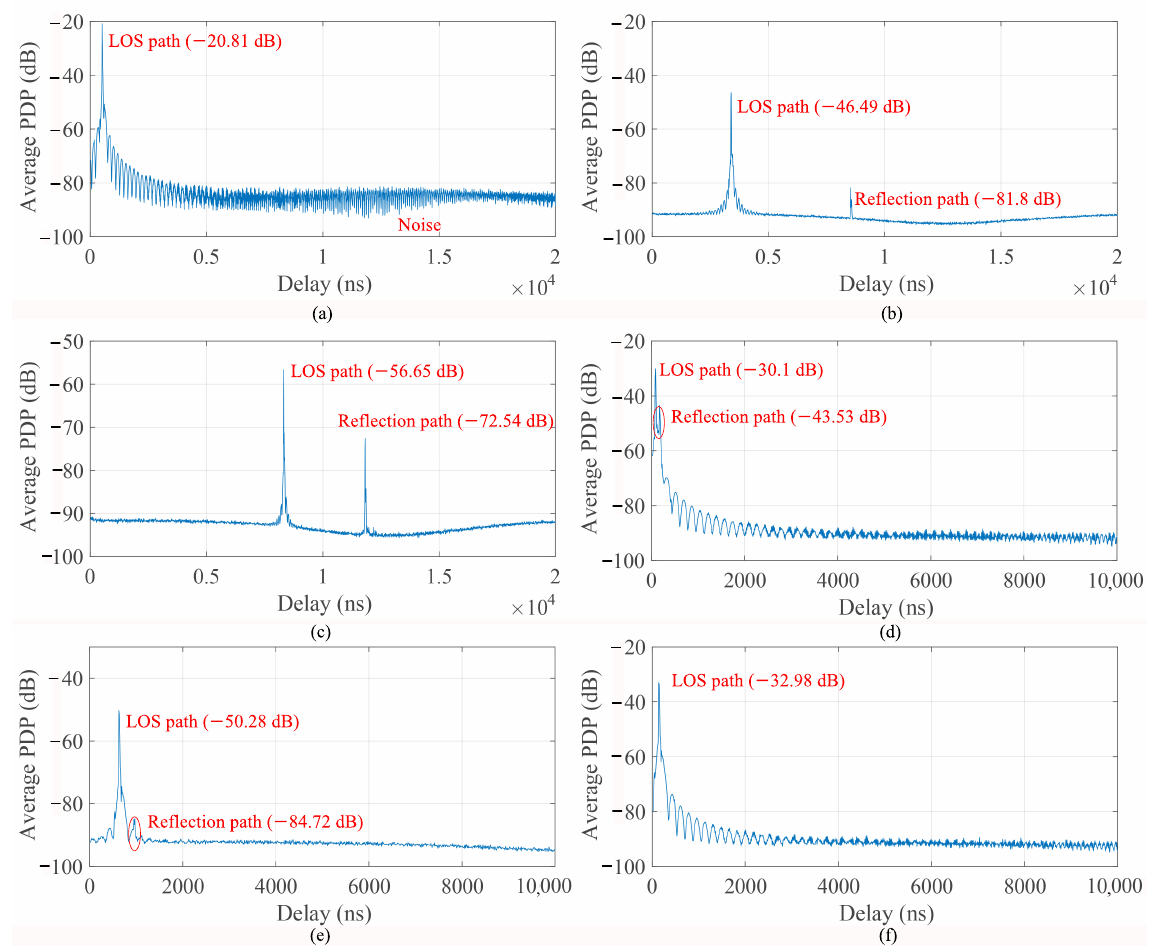
Figure 3. Average PDP from the three selected areas. ( a – c ) are Area I–III in S2I measurement, ( d – f ) are Area i–iii in S2S measurement. Table 2. Results of the average